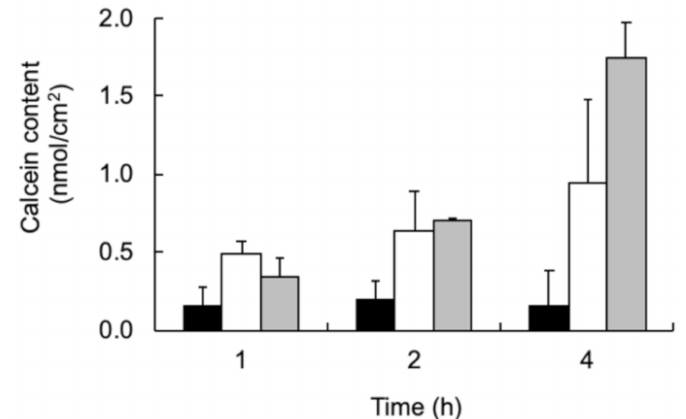
Figure 3. Calcein concentration in hairless mouse skin after the application of calcein aqueous solution or MEL-B liposomes containing calcein. Symbols: closed bar, 0.5 mM calcein aqueous solution; open bar, 0.5 mM calcein aqueous solution + 0.5% MEL-B liposomes; gray bar, 0.5 mM calcein aqueous solution + 1.0% MEL-B liposomes. Values are expressed as the mean ± S.D. of three experiments.